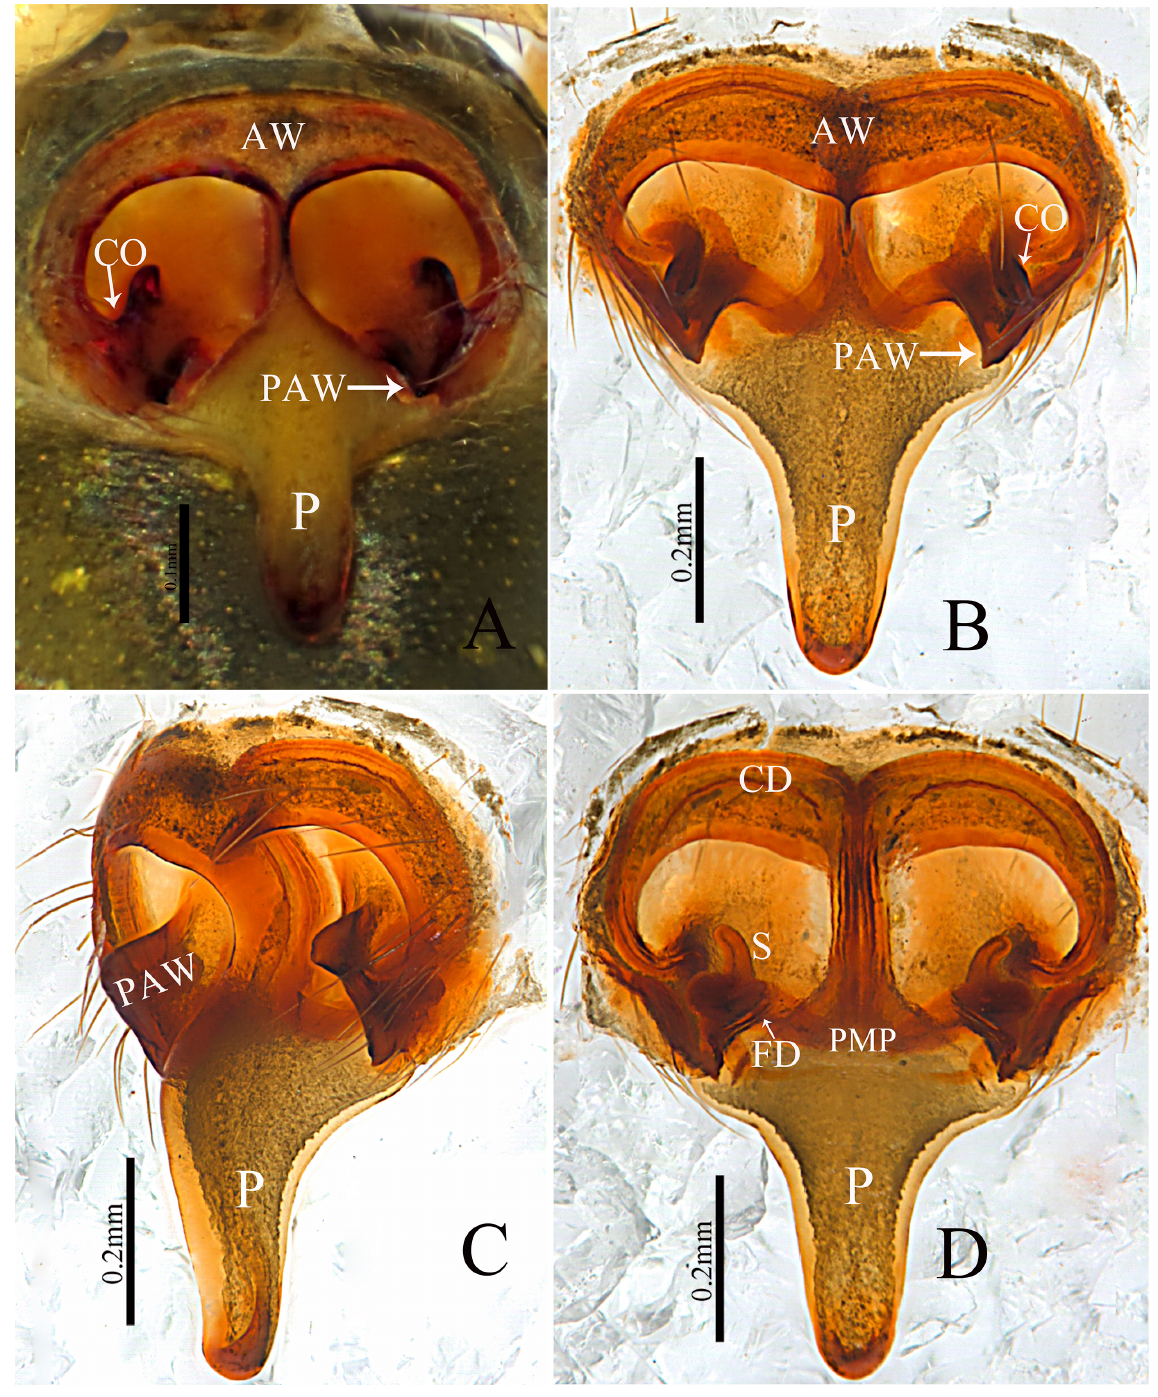
Fig. 8. Acroterius brevis gen. et sp. nov., ♀, paratype (HNU-20040501–2). A–B . Epigyne, ventral view. C . Epigyne, lateral view. D . Vulva, dorsal